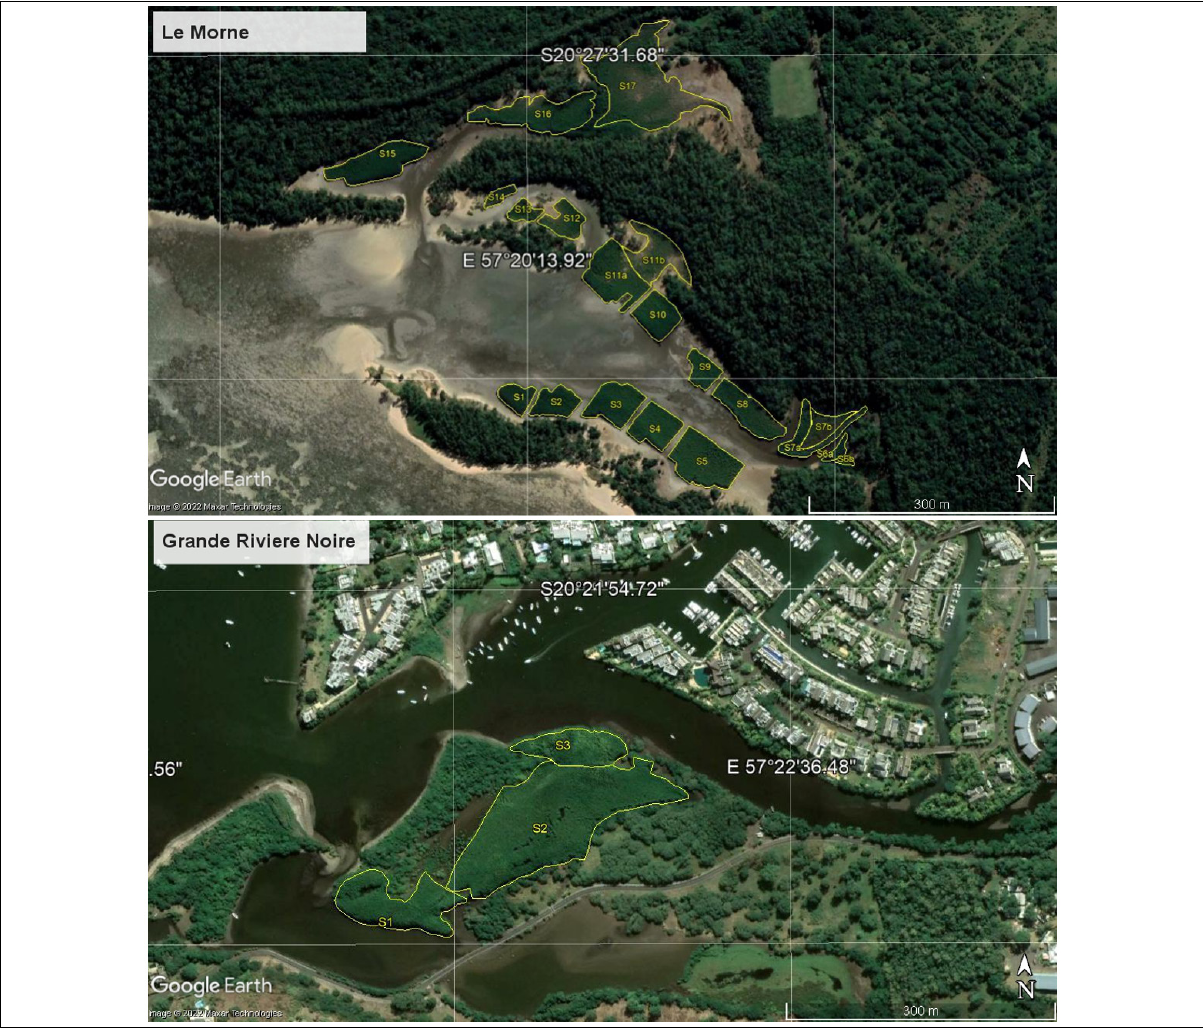
Figure 1: Google Earth Pro images (with 1 degree grid line) showing the mangrove study sites at Le Morne (top) and Grande Rivière Noire (bottom) along with their plot delineated by yellow boundaries; Le Morne (S1–S17) and Grande Rivière Noire